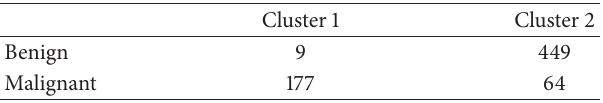
Table 5: Confusion matrix for the average clustering result with Hamming distance, for 𝑚 = 1.1 .